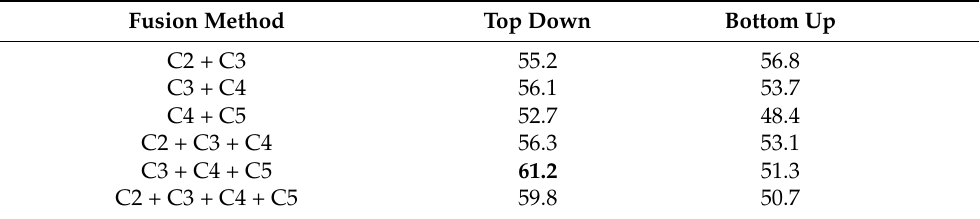
Table 4. Detection results of small-scale ships with different fusion